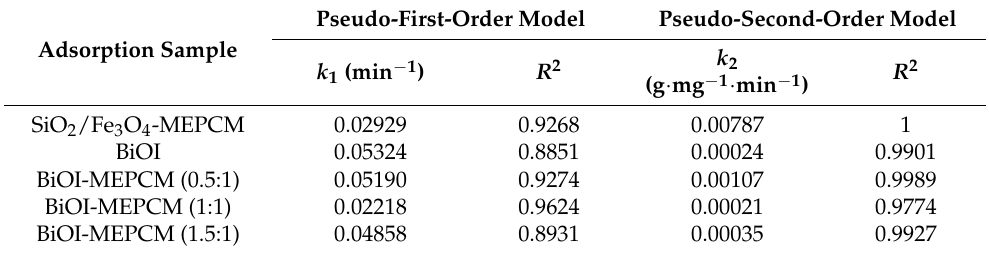
Figure 6. UV–vis absorption spectra of methyl orange during the adsorption process with ( a ) SiO 2 /Fe 3 O 4 -MEPCM, ( b ) BiOI, ( c ) BiOI-MEPCM (0.5:1), ( d ) BiOI-MEPCM (1:1), and ( e ) BiOI-MEPCM (1.5:1). ( f ) Adsorption ability of methyl orange during the adsorption process with BiOI and phase-change microcapsules. ( g ) Q t of BiOI and phase-change microcapsules as a function of adsorption time for adsorbing methyl orange. Linear kinetic adsorption plots of methyl orange using ( h ) pseudo-first-order and ( i ) pseudo-second-order kinetic models for BiOI and phase-change microcapsules. Table 1. Kinetic parameters of pseudo-first-order and pseudo-second-order models for methyl orange adsorption of phase-change